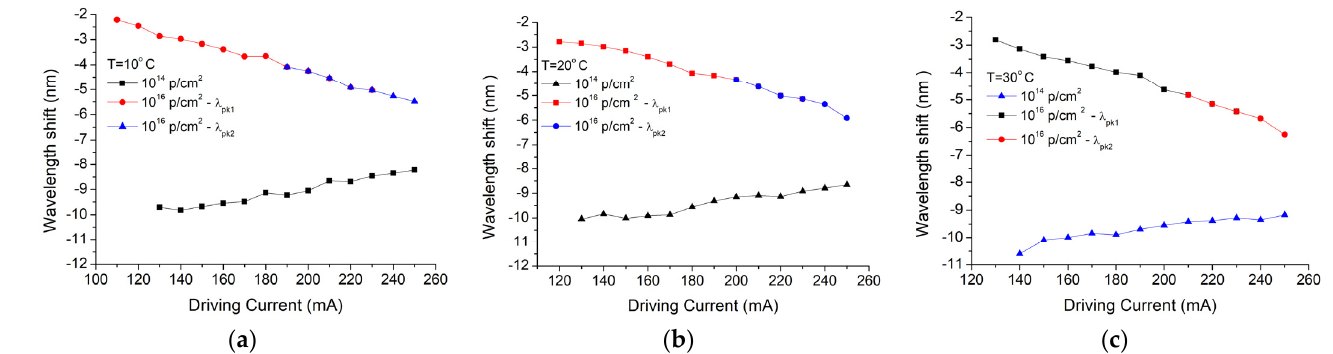
Figure 6. Protons irradiation impact (fluences of 10 14 p/cm 2 and 10 16 p/cm 2 ) on the driving current- induced central wavelength ( λ 1) shift for: ( a ) 10 °C, ( b ) 20 °C, ( c ) 30 °C.